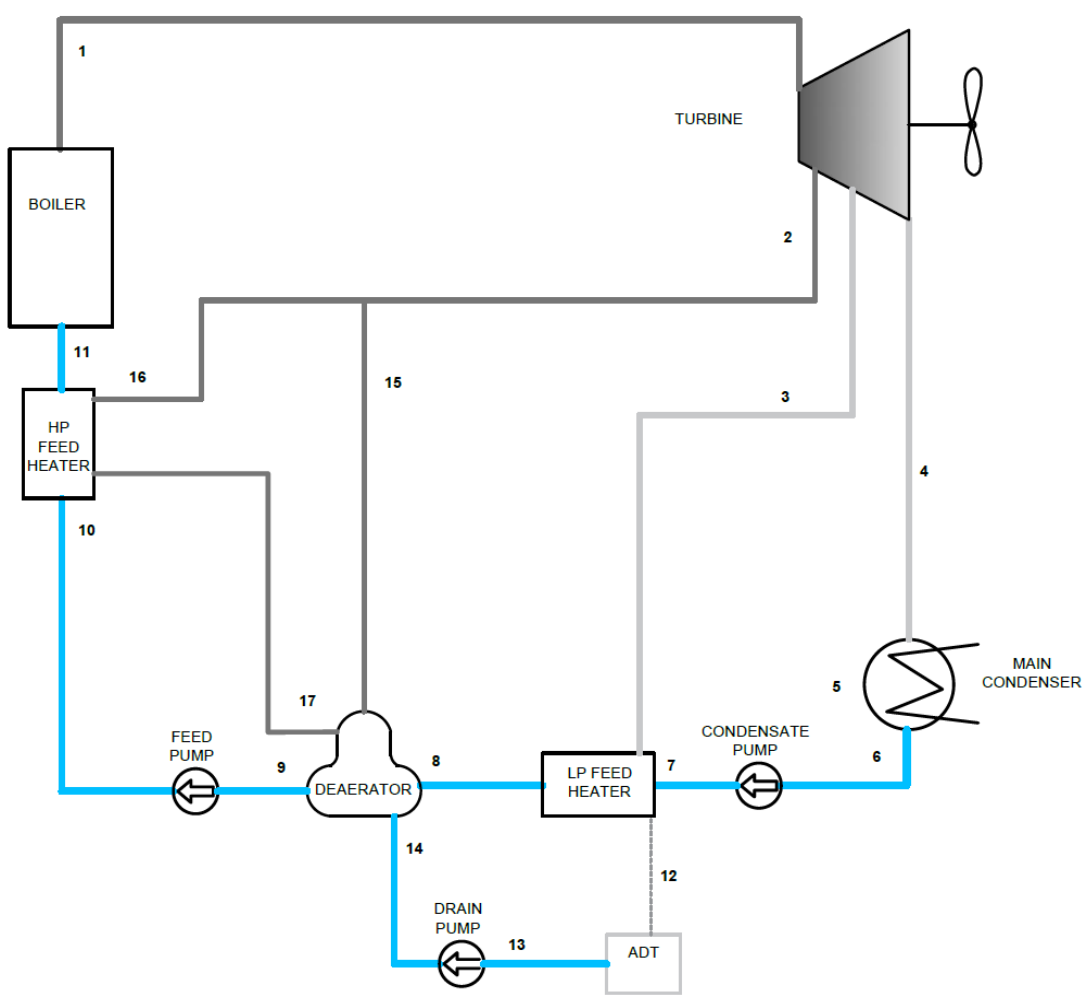
Figure 8. A thermal flow diagram of a reference cycle.